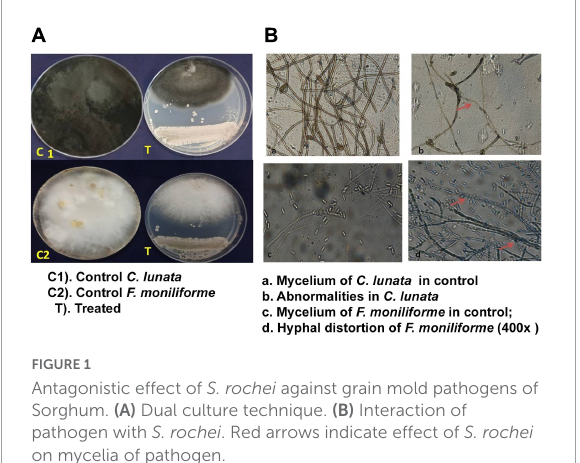
FIGURE3 Efficacy of crude metabolites of S. rochei against sorghum grain mold pathogens (agar well diffusion assay).